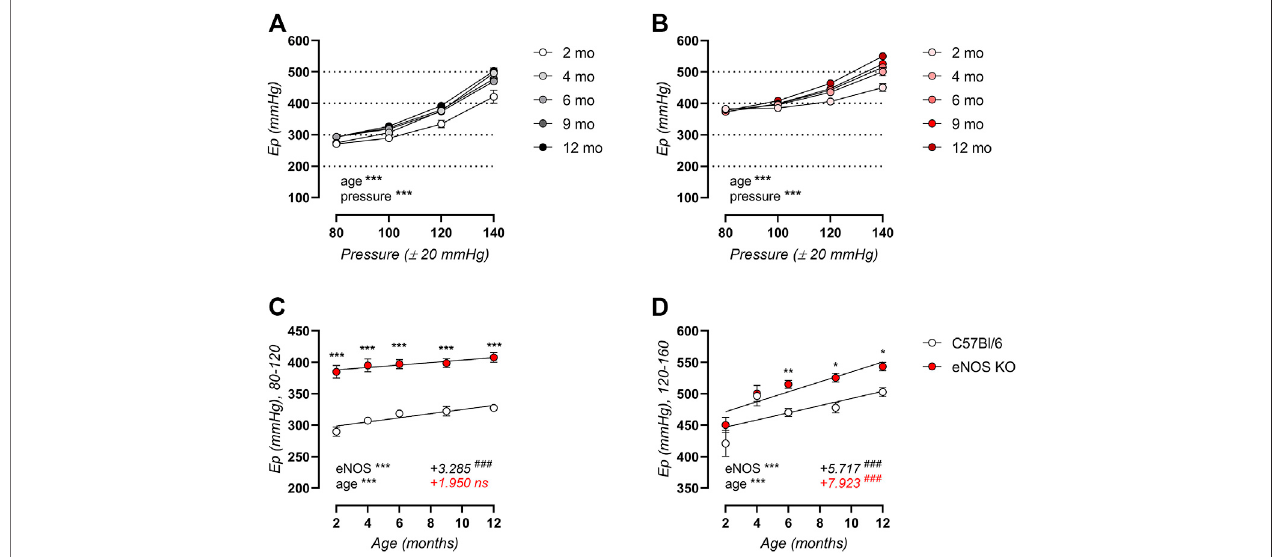
FIGURE2| Exvivo arterialagingislesspronouncedineNOSknockoutversusC57Bl/6controlmiceatphysiologicaldistendingpressure.Petersonmodulus(E p )in baselineKrebs-RingerconditionsoverabroadpressurerangeisdisplayedforagingC57Bl/6control( n > 9) (A) andeNOSknockout( n > 9) (B) mice.DetailedviewsofE p at physiological (calculated 80 – 120 mmHg) (C) and high (calculated 120 – 160 mmHg) (D) distending pressure are shown. Age-dependent changes in (C,D) were analyzedusinglinearregression(slopedisplayed,bottomright).AnF-testwasusedtoassessiftheslopewasdifferentfromzero.Statisticalanalysisusingtwo-way ANOVA. Overall signi fi cance (bottom left) and post-hoc signi fi cance (in graph) are listed. No post-hoc signi fi cance is listed in (A,B) . ANOVA: ns, p > 0.05; *, p < 0.05; **, p < 0.01; ***, p < 0.001. F-test: ns, p > 0.05; ###, p < 0.001.